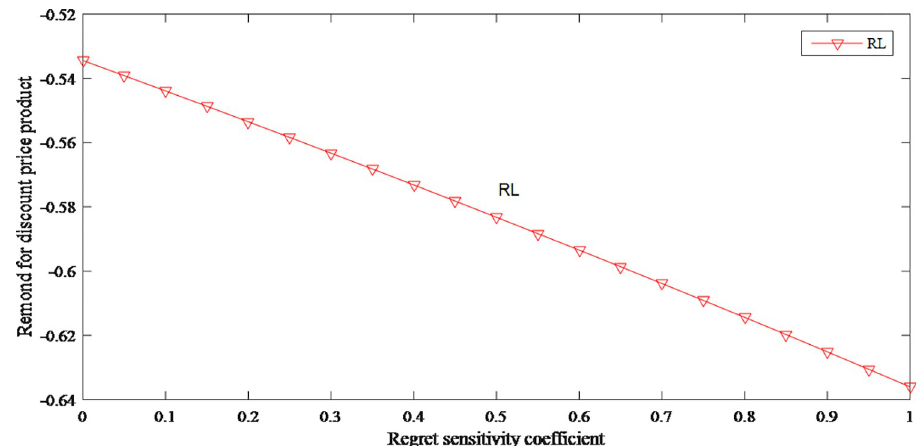
Fig 4. The impact of anticipated regret on demand for discount price product.